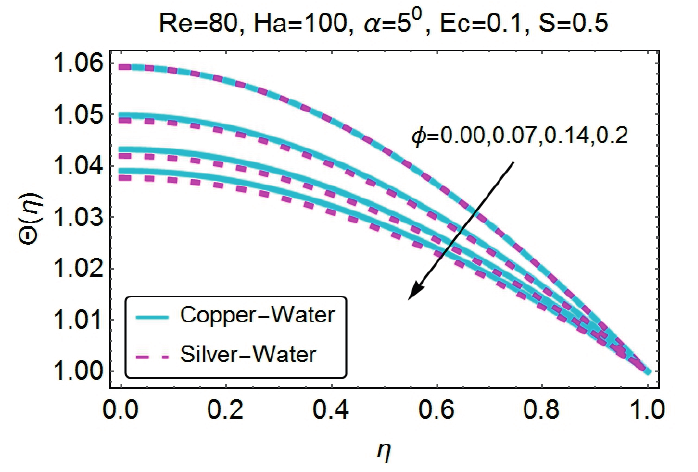
Figure 16. Change in temperature for varying ϕ (divergent channel/stretching case).